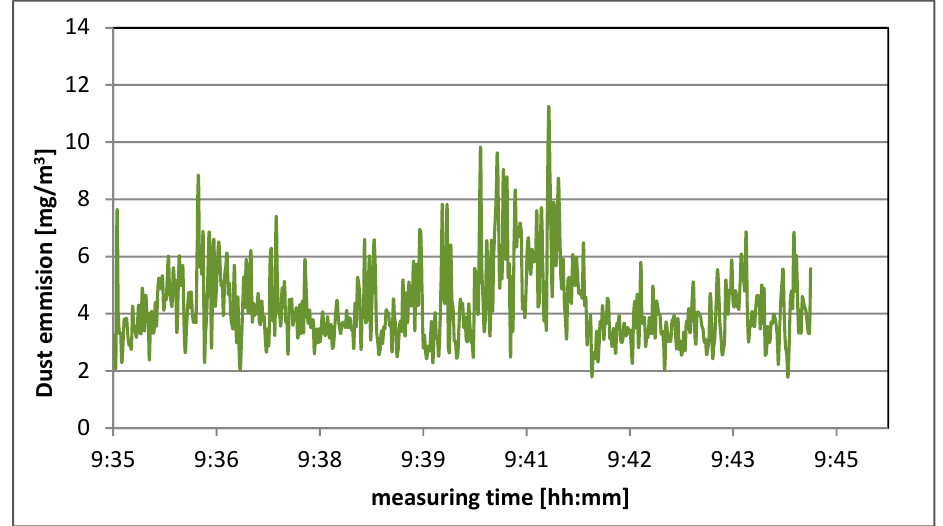
Figure 16. Dust generation for irregular particles—feed material 𝑥̅ = 4.91, s = 1.84 .